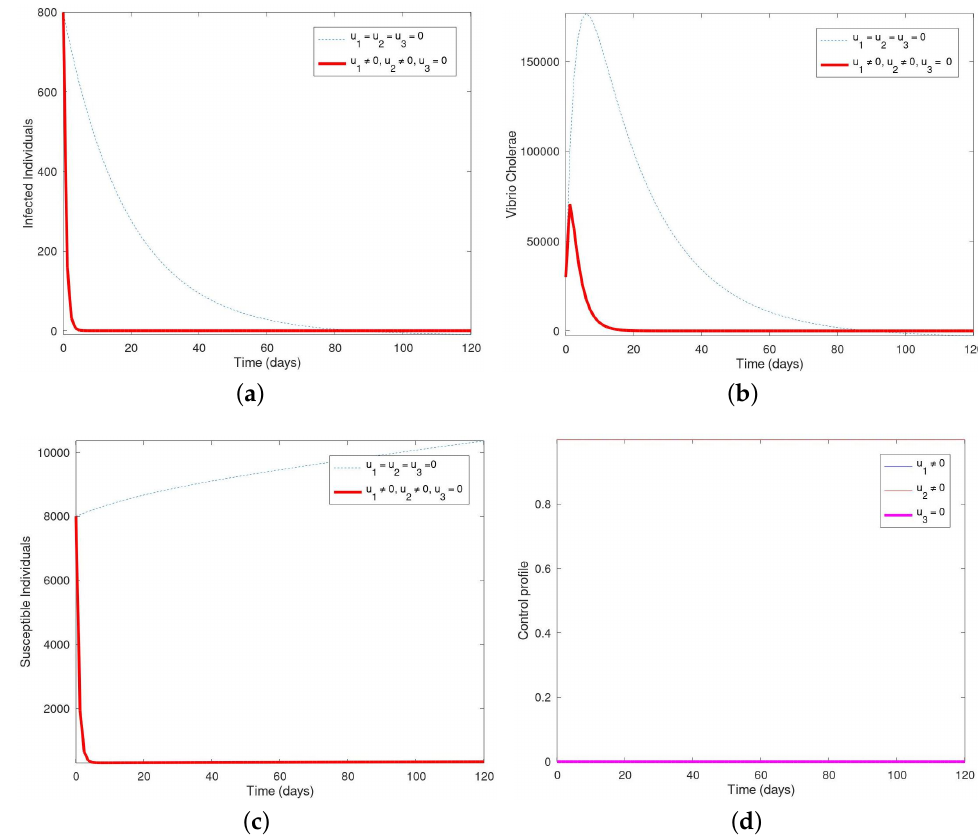
Figure 4. Simulation showing the population of ( a ) infected, ( b ) vibrio cholerae, ( c ) susceptible and ( d ) the control profile with ( u 1 , u 2 ) . In Figure 4a, the population of the infected human decreases drastically within the first 5 days and cholera was totally wiped out. In Figure 4b, the number of vibrio cholerae increases and then decreases until it vanishes. In Figure 4c, the number of susceptible humans completely decreases and vanishes from the system in the presence of the control intervention but increases without the control interventions. In Figure 4d, the control profile showed that the control ( u 1 ) and ( u 2 ) remained constant from day 1 till the end of the 120 days while ( u 3 ) maintained lower